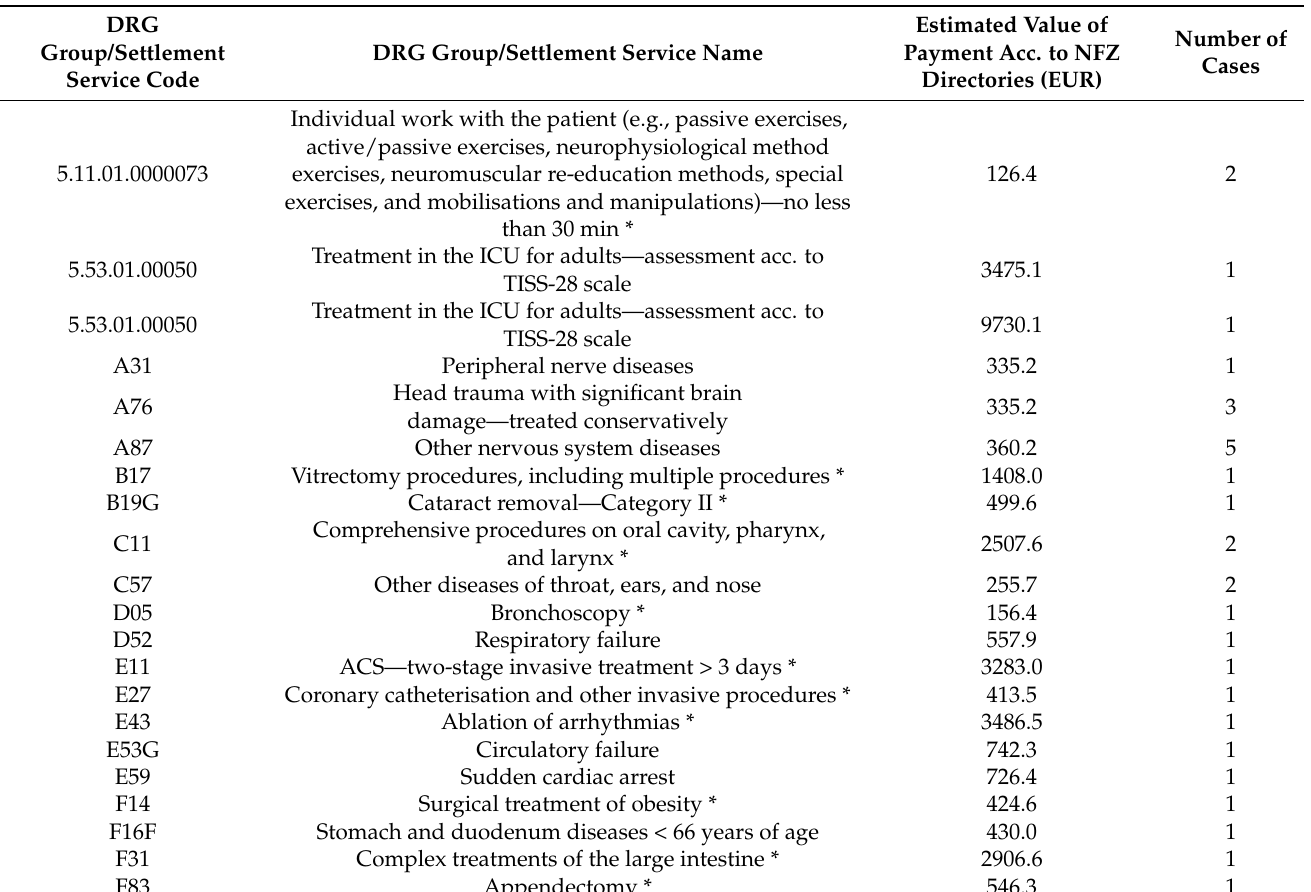
Table 2. Type of provided services, their number, and costs of treatment of the consequences of event (secondary harm) in accordance with the directories by the National Health Fund President.